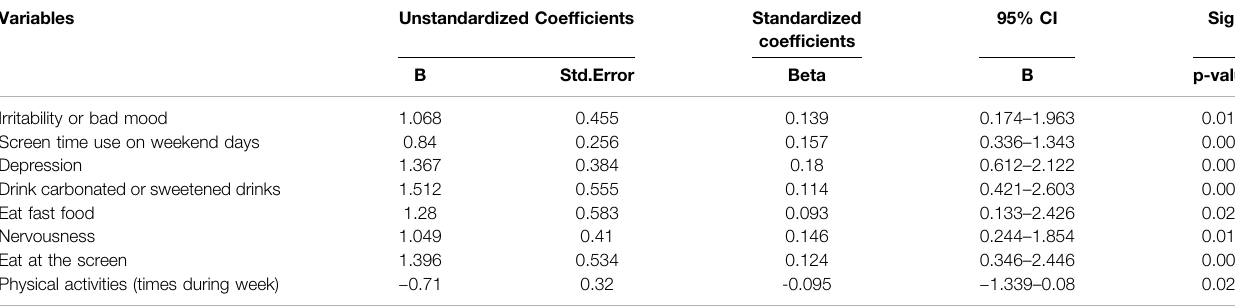
TABLE 3 | Stepwise multiple linear regression model examining associations with the PRIUSS.